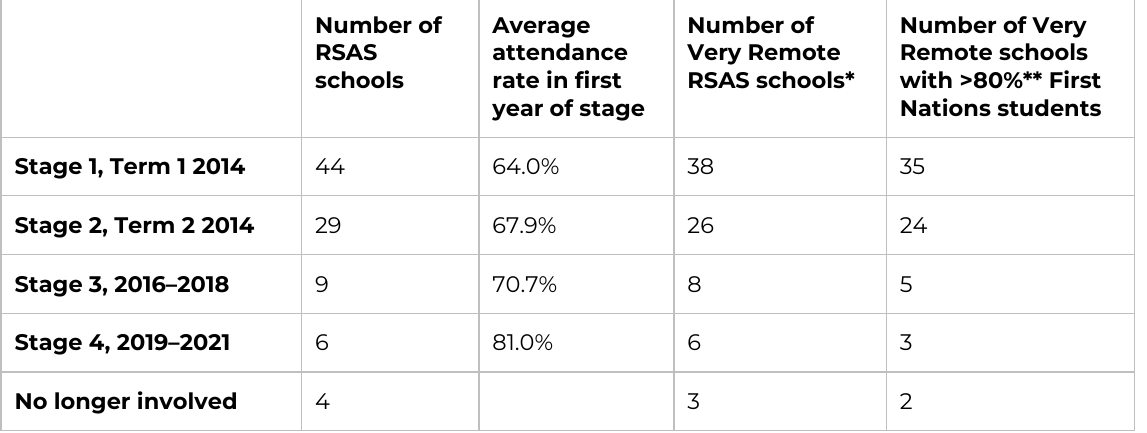
Number of Average RSAS Very Remote rate in first schools year of stage